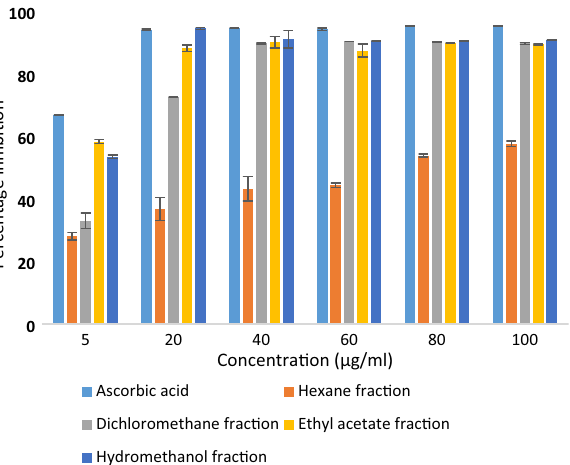
Table 3 IC and IC A. floribunda stem bark fractions 50-DPPH 50 Pf3D7 of